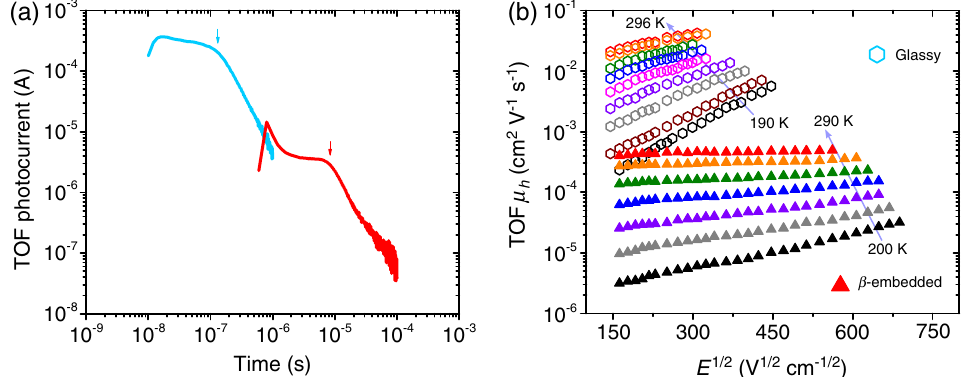
FIG. 2. (a) Representative TOF photocurrent transients for glassy (blue line) and β -phase embedded (red line) HMW PFO devices. ¼ 10 V, i.e., at All films had very comparable thickness ( ∼ 1 . 8 μ m), and measurements were performed under identical conditions ( V bias E ≈ 5 . 6 × 10 4 V cm − 1 ; and T ¼ 290 K). For each case, the carrier transit time t (indicated by an arrow) was extracted by locating the tr point of intersection of two tangents (omitted for clarity) fitted to the pre- and post-transit regimes of the transient on the double- logarithmic scale. The variation in onset of the initial spike reflects the different choices of the temporal resolution or window to best capture the photocurrent transients. No manual offset was applied to the transients, and the photocurrent levels are absolute. (b) Poole- Frenkel plots of TOF hole mobility ( μ ) as a function of the square root of applied electric field, measured at different temperatures for h HMW TOF devices made with pristine glassy PFO (top set, open hexagons) and with PFO containing β -phase structural minority introduced by exposure to toluene vapor for an hour (bottom set, filled triangles). Gaussian disorder model analysis of these data is — 190, 200, 215, 230, 245, 260, 270, 290, and presented in Appendix F. The temperatures measured were — in order of increasing μ h 296 K for the glassy set; and 200, 215, 230, 245, 260, 275, and 290 K for the β -phase embedded